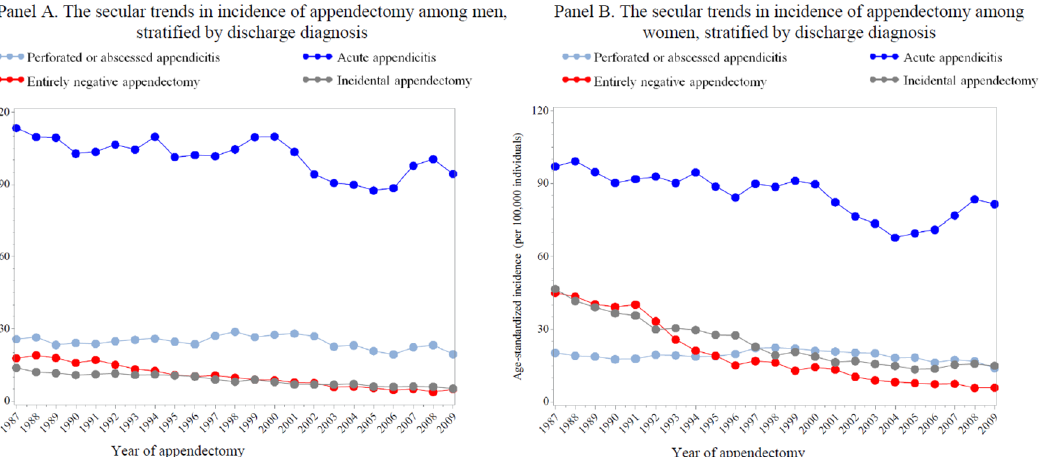
Fig 2. The secular trends in age-standardized incidence of appendectomy among men and women, stratified by discharge diagnosis. Panel A. the secular trends in age-standardized incidence of appendectomy among men, stratified by discharge diagnosis; Panel B. the secular trends in age- standardized incidence of appendectomy among women, stratified by discharge